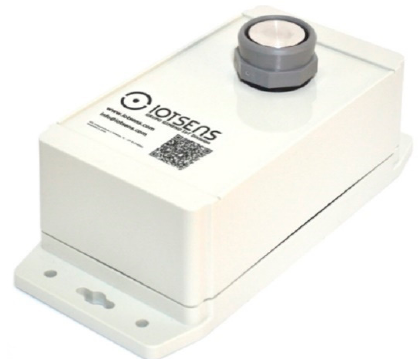
Figure 4. IoTsens waste